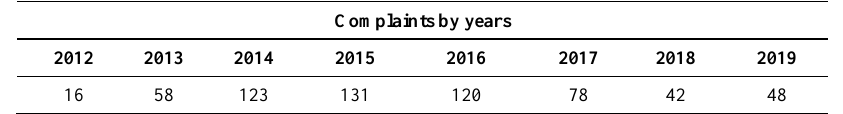
Table 2. Agency Presentation of the trend of AIP complaints by year in the Civil Registration Agency by